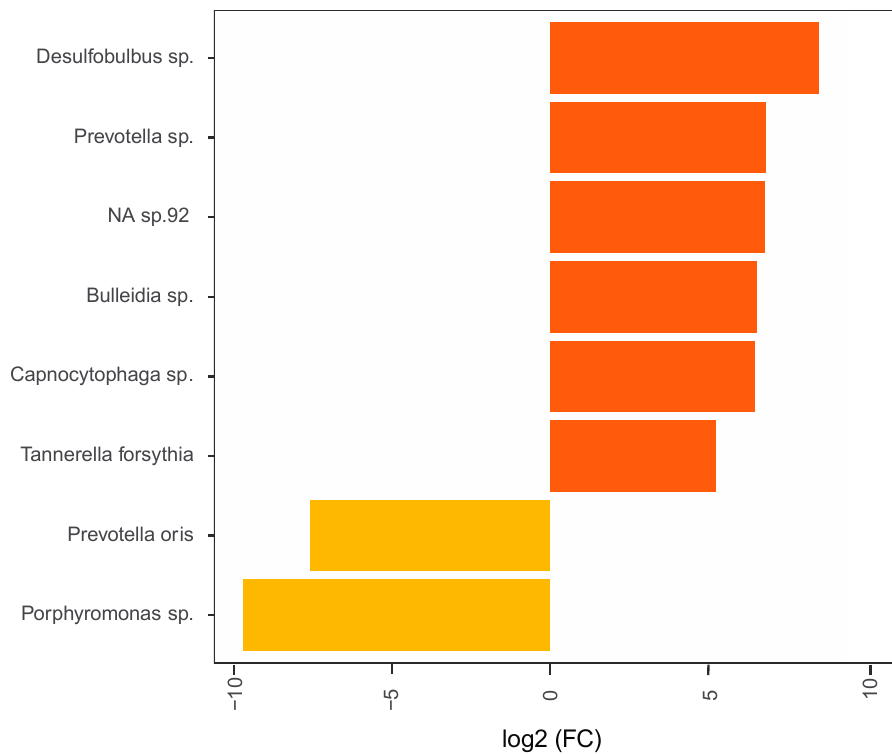
Figure 3. Most highly differentially abundant bacteria in plaque from patients with RA in relation to periodontitis severity. The graph demonstrates log2 Fold Change (FC) for the most highly enriched and depleted bacteria in plaque from RA patients with no/mild and moderate/severe periodontitis. Negative log2 FC indicate higher abundance in patients with no/mild periodontitis (light orange bars) and positive values indicate higher abundances in those with moderate/severe periodontitis (dark orange bars). NA, genome reference not available. The differences between the groups were analysed using DESeq2 [40]. *Adjusted p value < 0.05 was considered statistically significant.